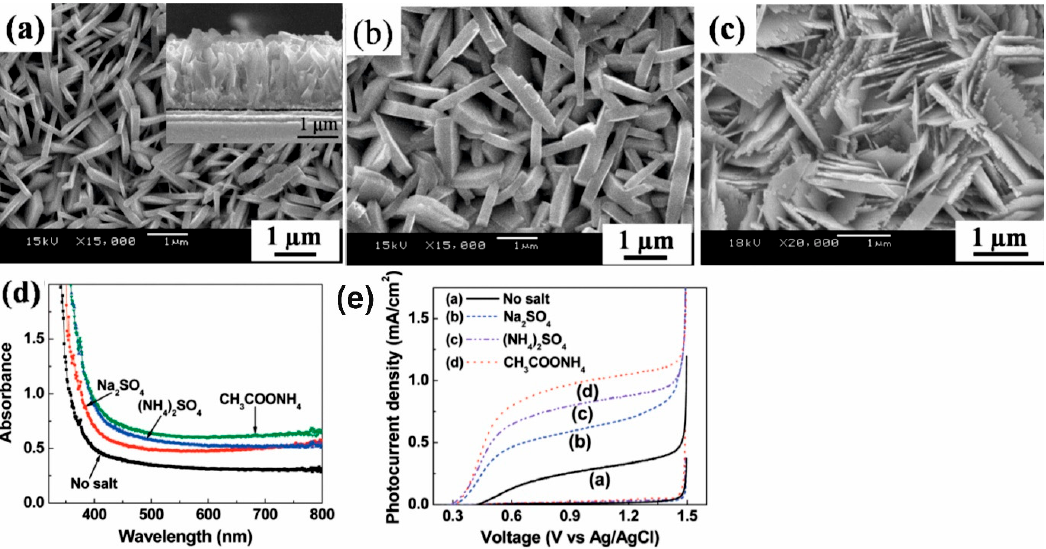
Figure 8. SEM images for WO 3 hydrate film with sheetlike nanostructures with ( a ) (NH 4 ) 2 SO 4 , ( b ) Na 2 SO 4 and ( c ) CH 3 COONH 4 as capping agent; ( d ) absorption spectra of WO 3 films; ( e ) current-potential scans of WO 3 films measured in darkness and under illumination in a 1-M H 2 SO 4 electrolyte containing 0.1-M methanol. Reproduced from [97], with permission from American Chemical Society, 2011.